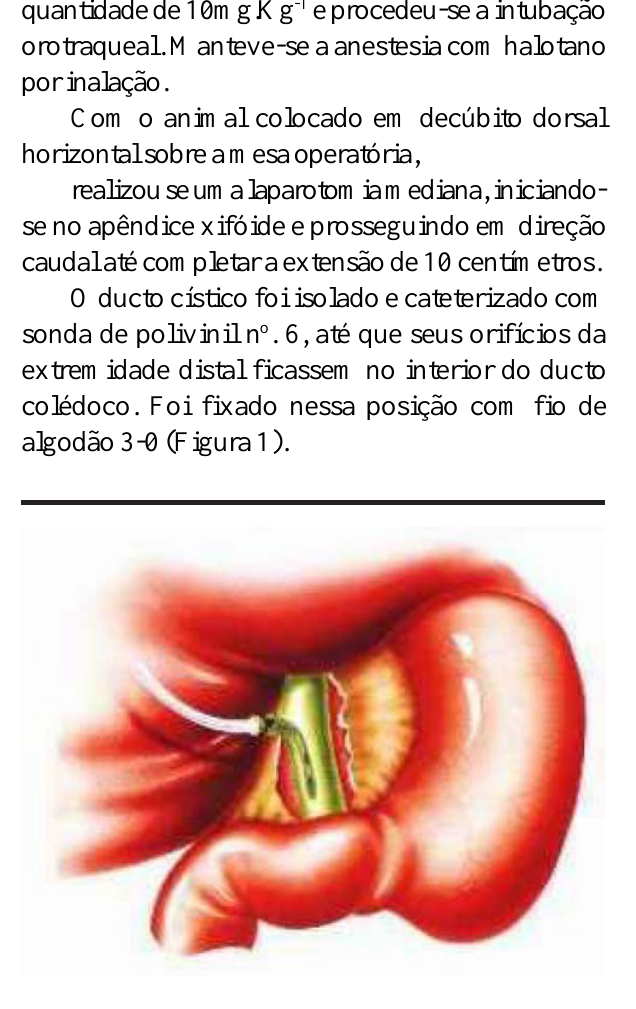
FIGURA 1 - Desenho mostra a sonda de polivinil posicionada no colédoco.